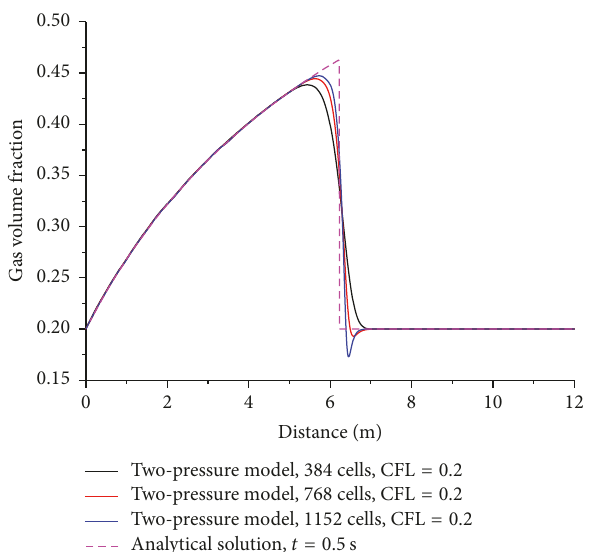
Figure 7: Numerical results of gas volume fraction using two- pressure model and FOU scheme with finer cells at time of 0.5 seconds.